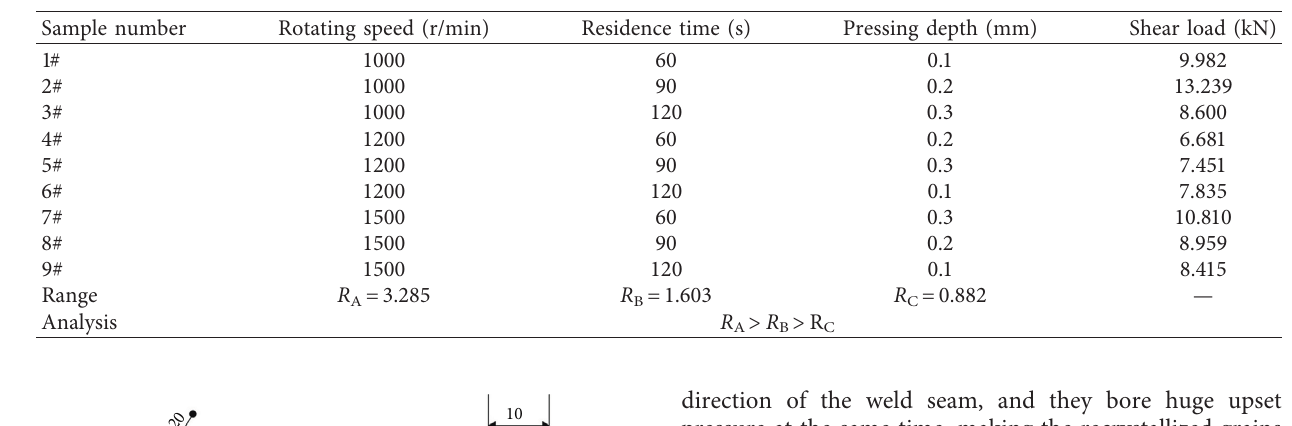
Table 3: Joint shear load.